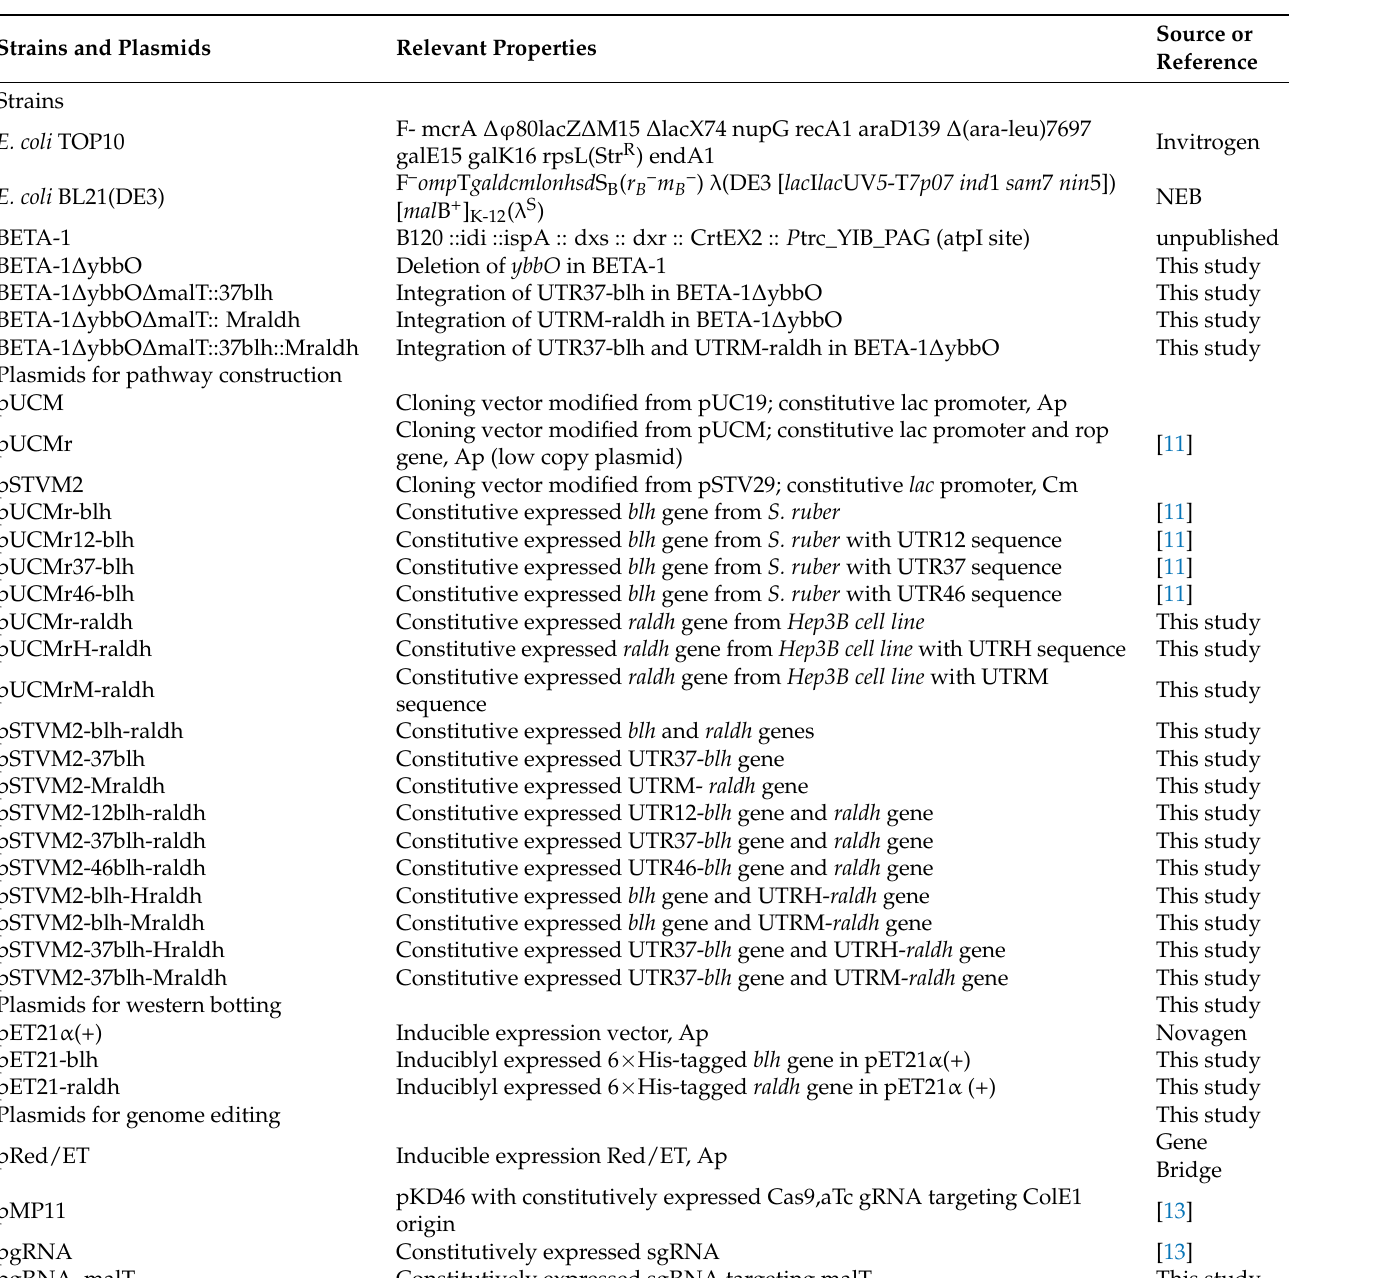
Table 1. Strains and plasmids used in this